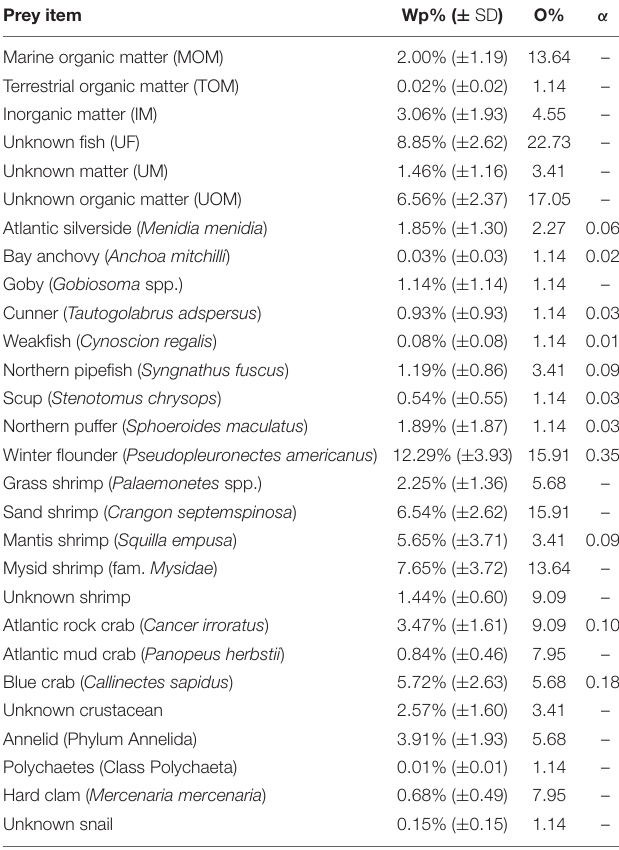
TABLE 3 | Diet composition of summer flounder collected in Shinnecock Bay